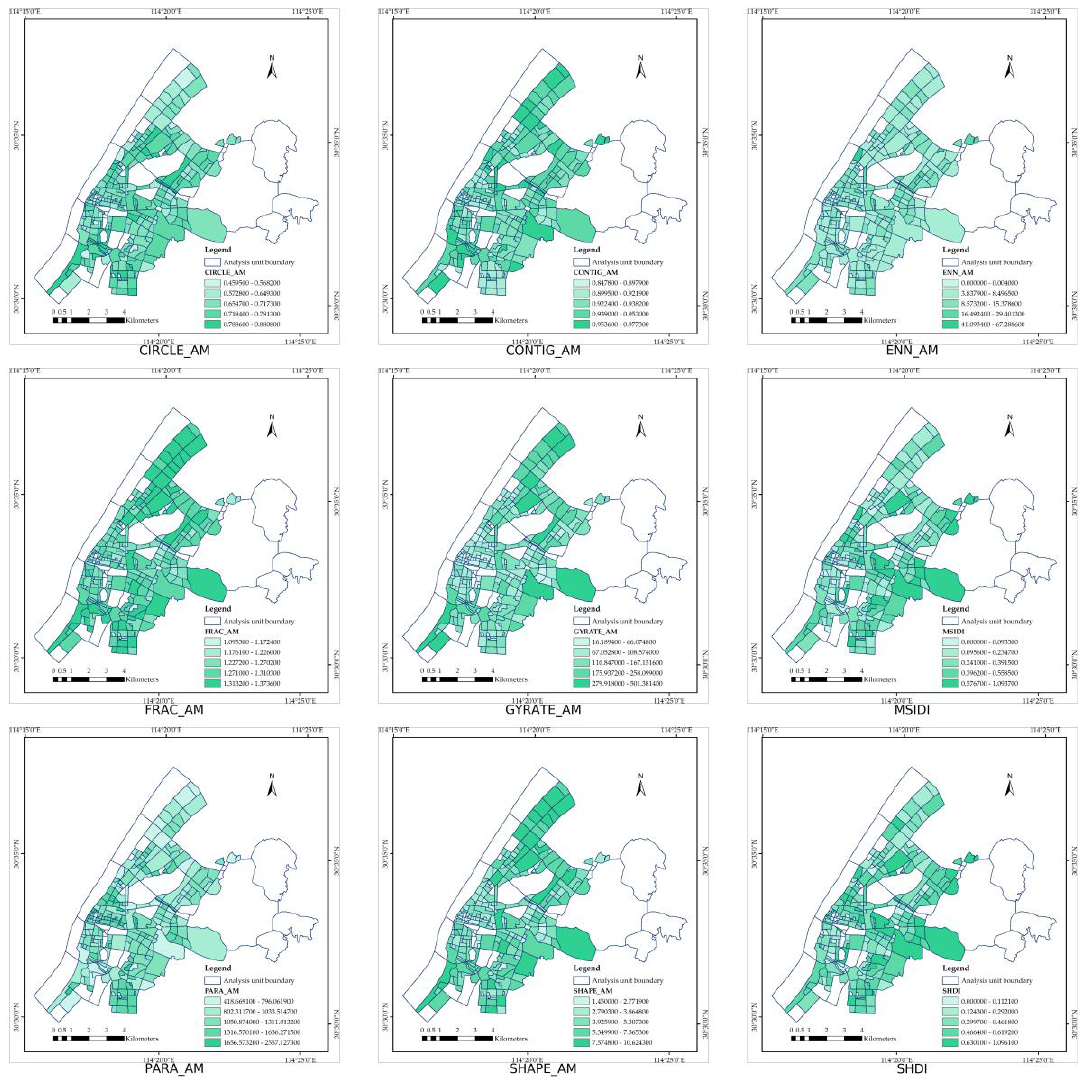
Figure 7. The spatial distribution of landscape metrics, in turn, containing CIRCLE_AM,